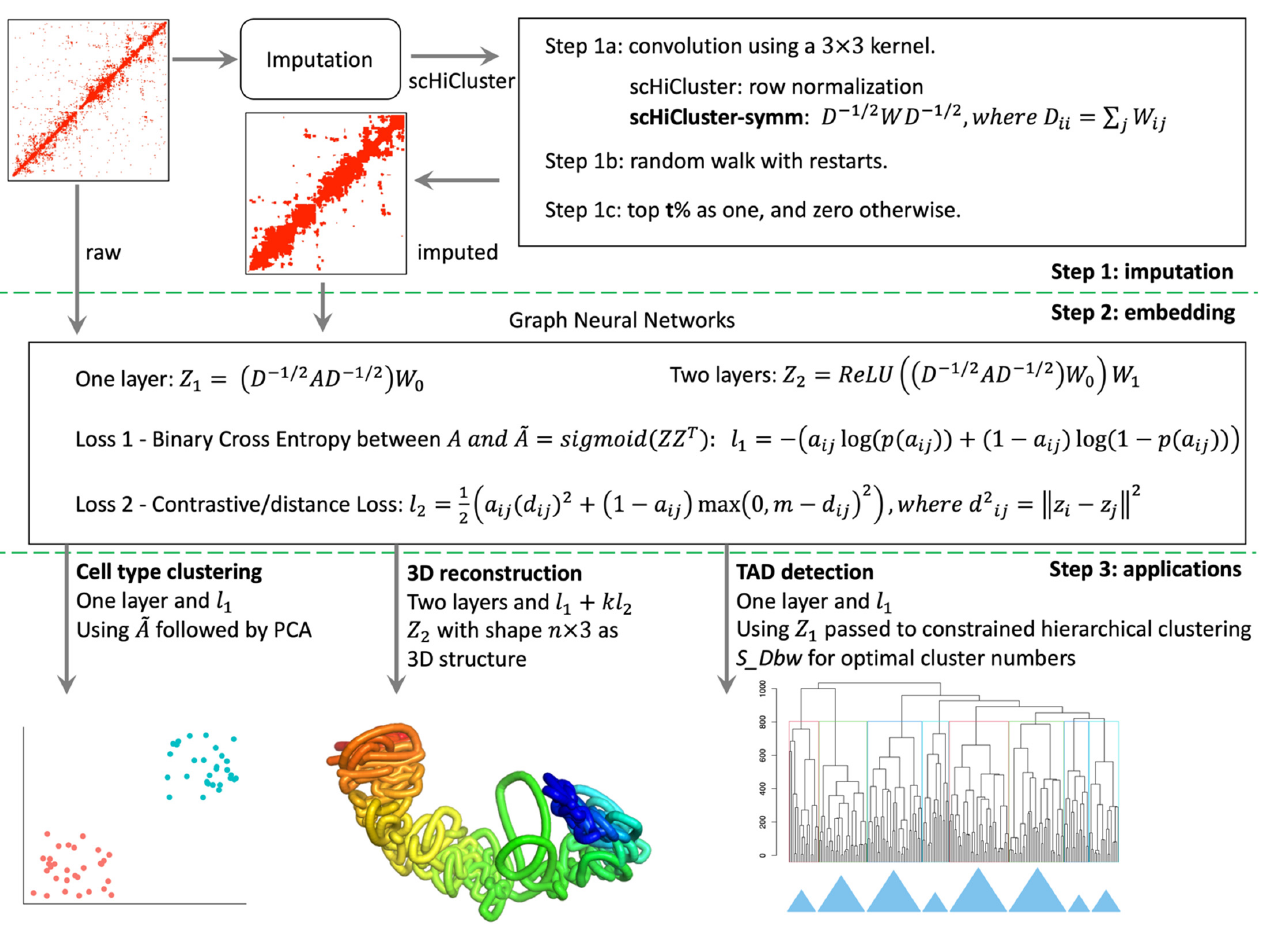
Figure 1. The scHiCEmbed pipeline. It contains three main steps: (1) imputation with revised scHiCluster, (2) embedding with graph auto-encoders, and (3) applications for cell-type identification, 3D structure reconstruction, and TAD detection.